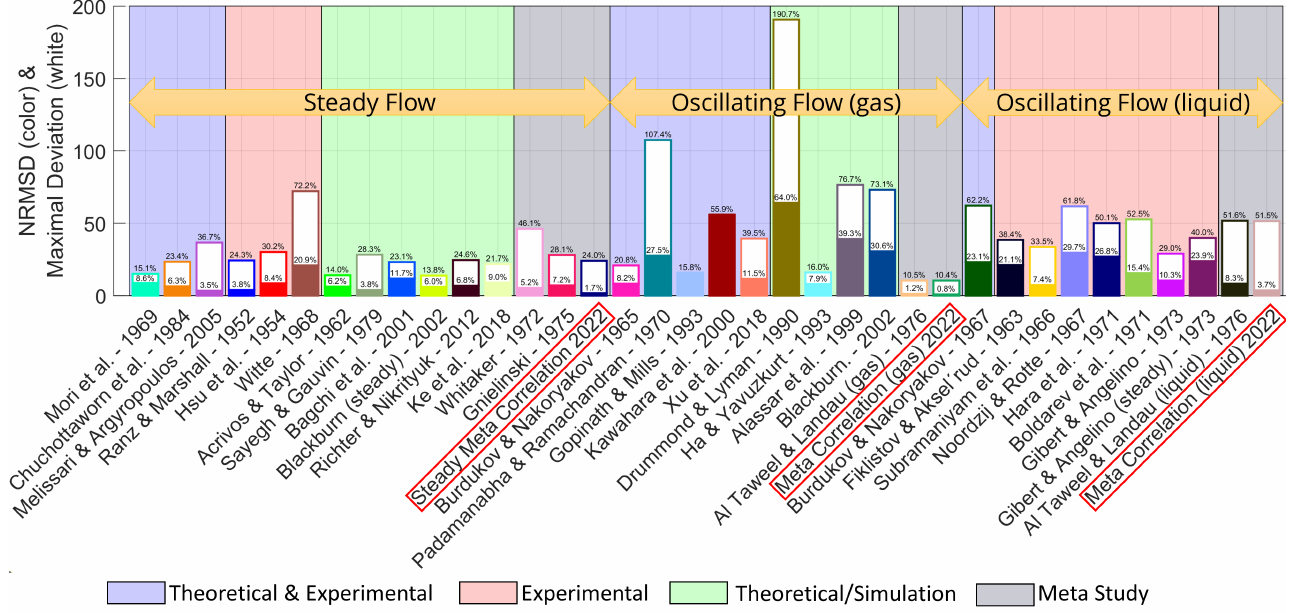
Figure 5. Deviations of Meta-Correlation (4) and (5) to the respective individual models investigated and listed in Table 1. The colored bars give the NRMSD , calculated with Equation (3), while the white bars give the maximum normalized deviation. The deviation presented for Meta-Correlations (4) and (5) is for all investigated models and data